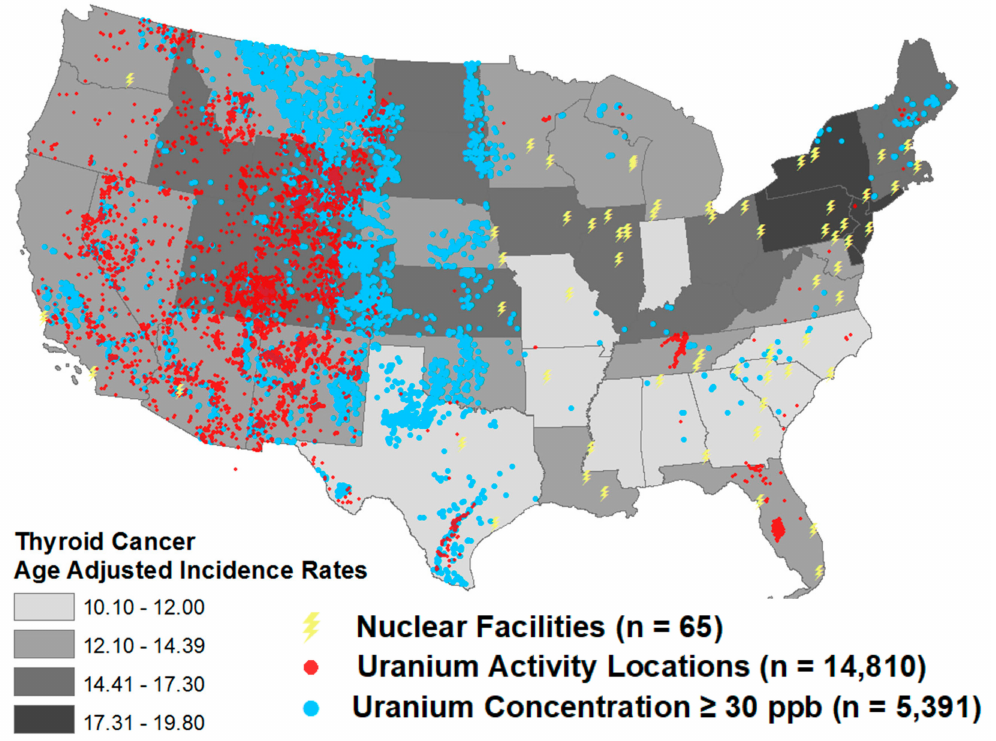
Figure 3. Distributions of age-adjusted thyroid cancer incidence rates per state and sources of uranium exposure, including uranium concentrations in